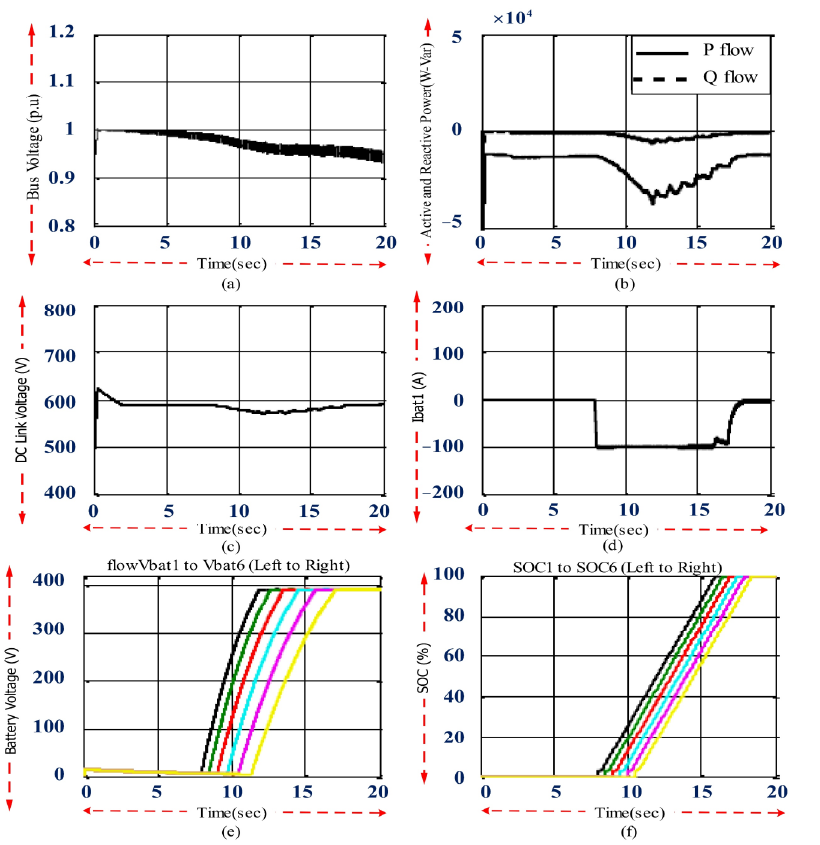
Figure 17. Fast charging results of EVs in microgrid and stand-alone and off-grid conditions ( a ) generator voltage; ( b ) active and reactive power exchange; ( c ) DC link voltage; ( d ) battery current; ( e ) battery voltage; ( f ) SOC.